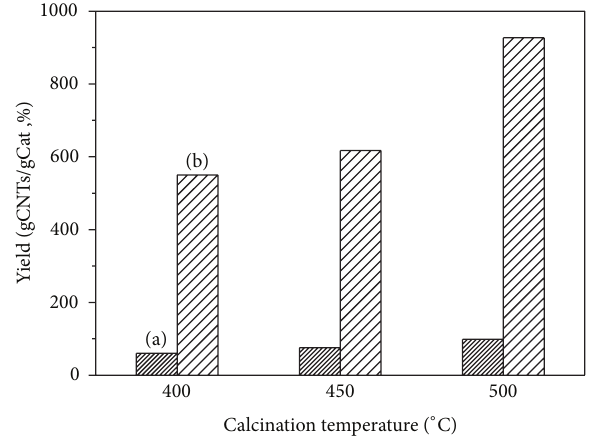
Figure 3: Yield of carbon on the catalysts (a) Ni/MgO and (b) Ni- Cu/MgO calcined at different temperatures (reaction temperature at 650 ∘